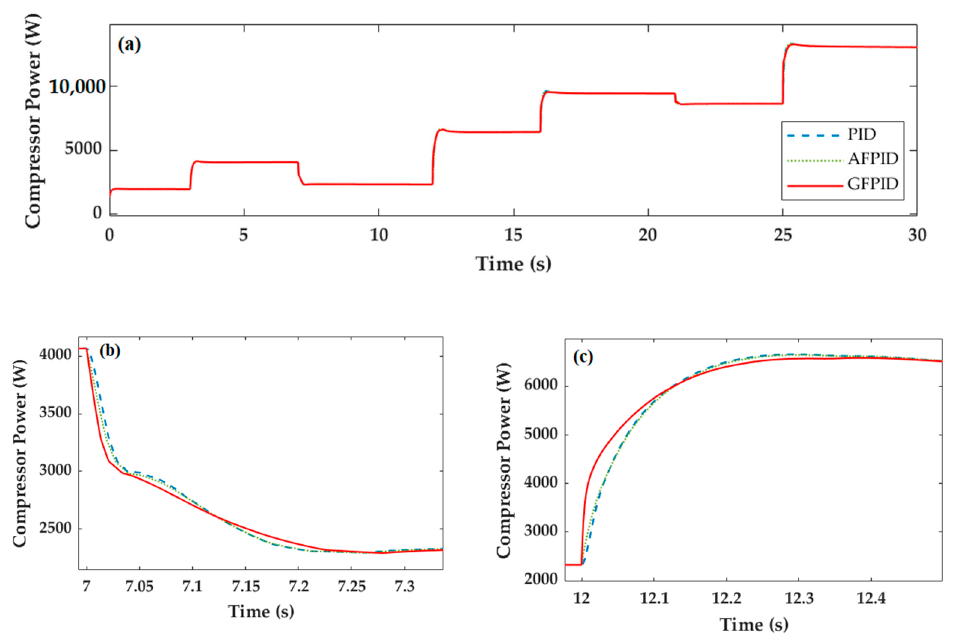
Figure 13. PEMFC parameters: ( a ) 30 s of compressor power; ( b ) compressor power at 7 s; ( c ) com- pressor power at 12 s.